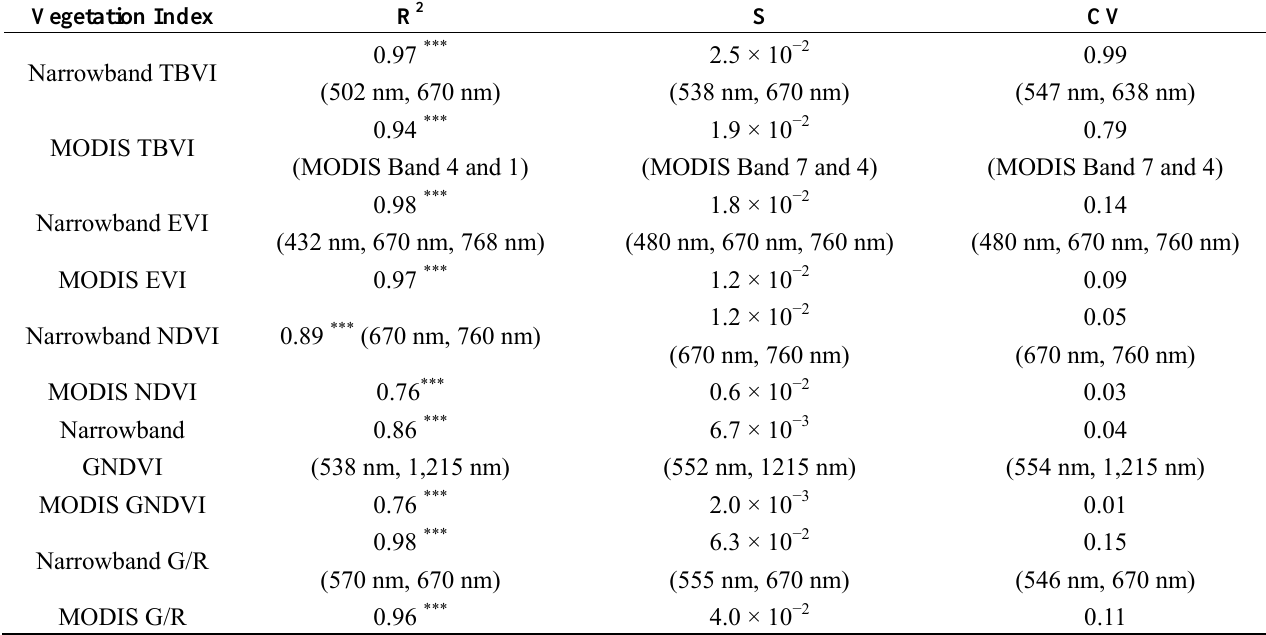
Table 2. Narrowband positions resulting in the maximum values of R 2 , S, and CV, along with corresponding MODIS broadband for different vegetation indices. Narrowband TBVI was made with the region of MODIS Bands 4 and 1.